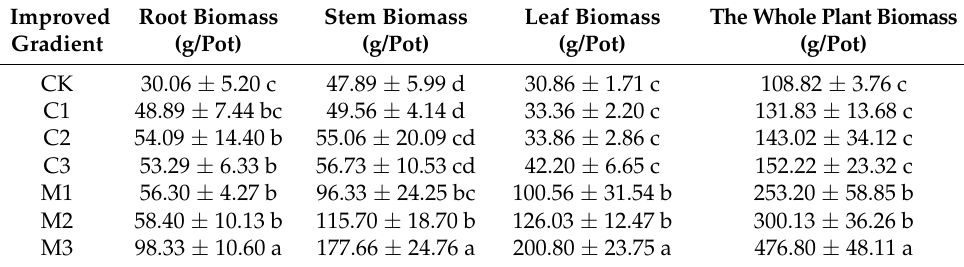
Table 3. Nerium indicum biomass increase in different organs with different modified treatments.